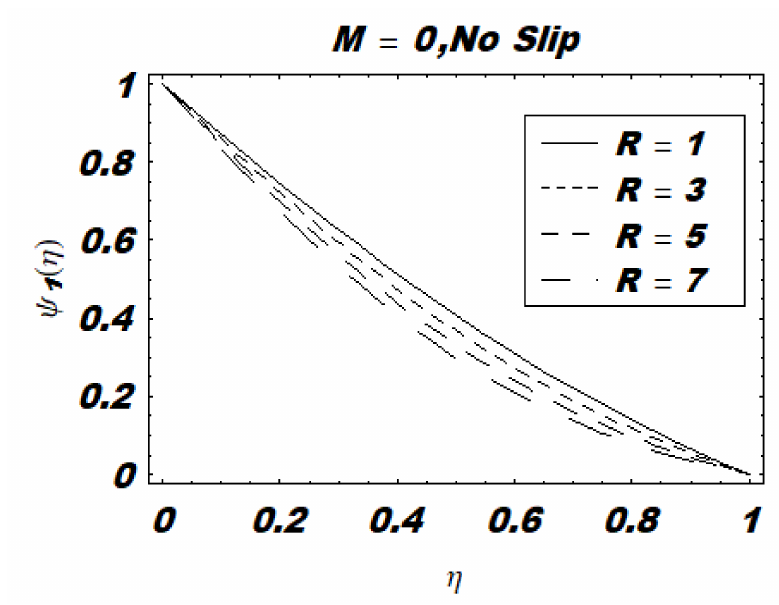
for the circular slider. 3